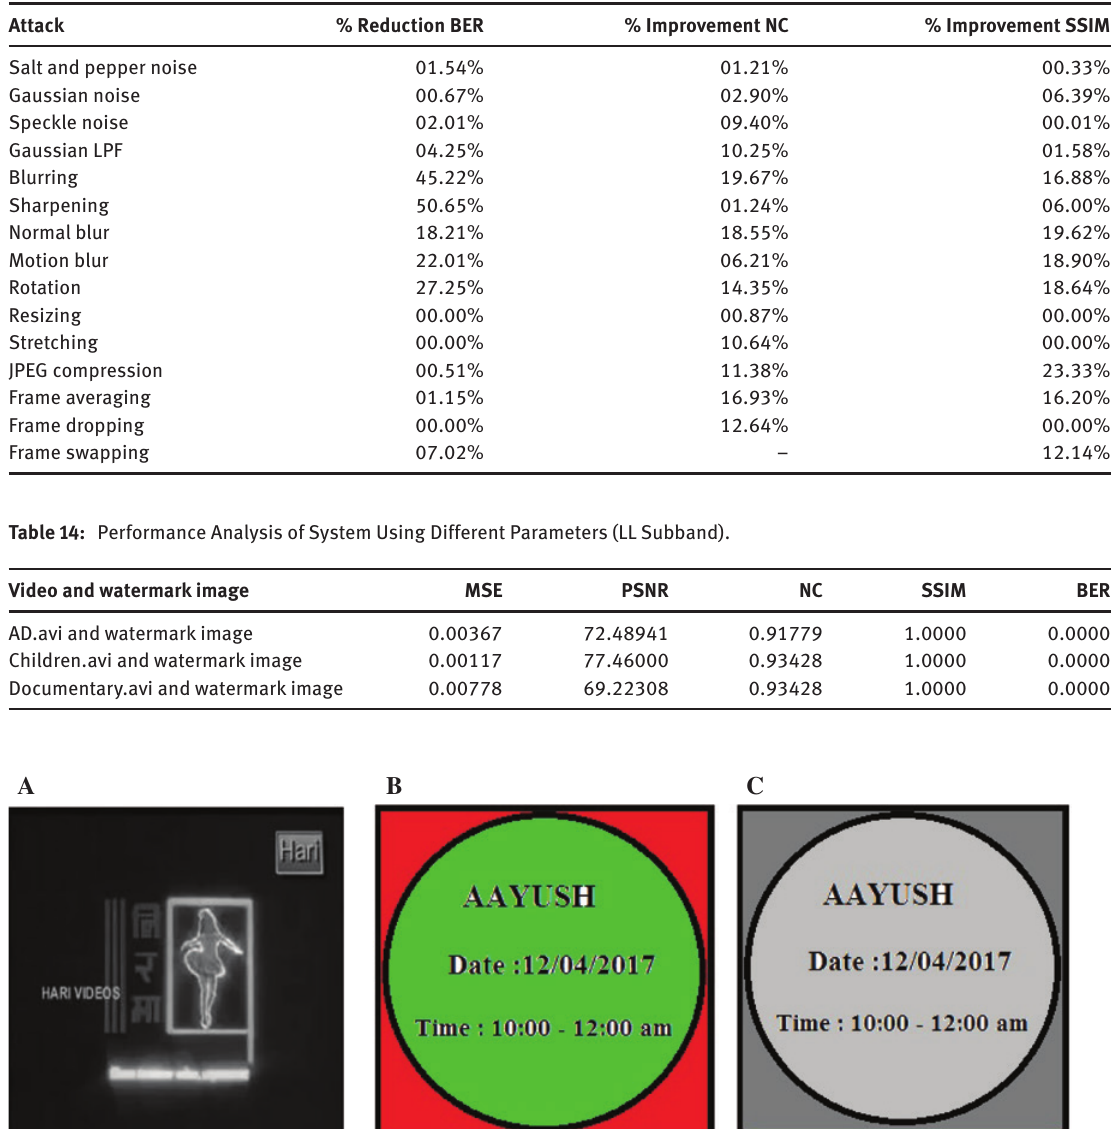
Table 13: Improvement in the Result with the LL Subband.